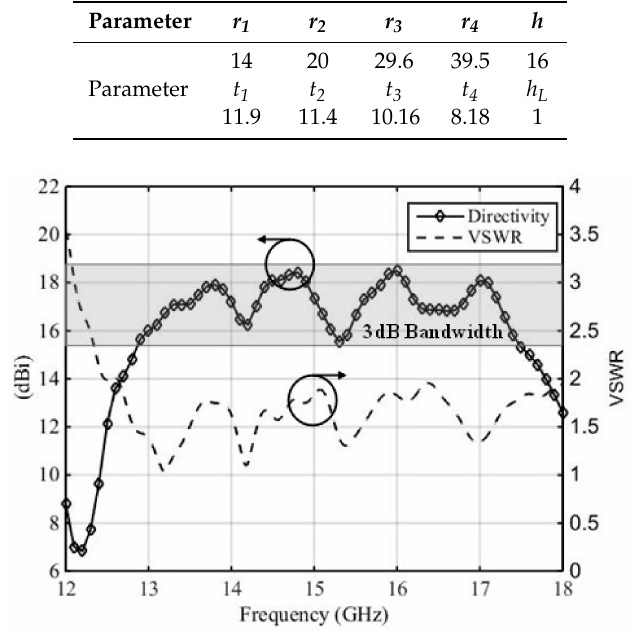
Figure 4. Broadside directivity and input matching of the RCA with planar stripline-fed